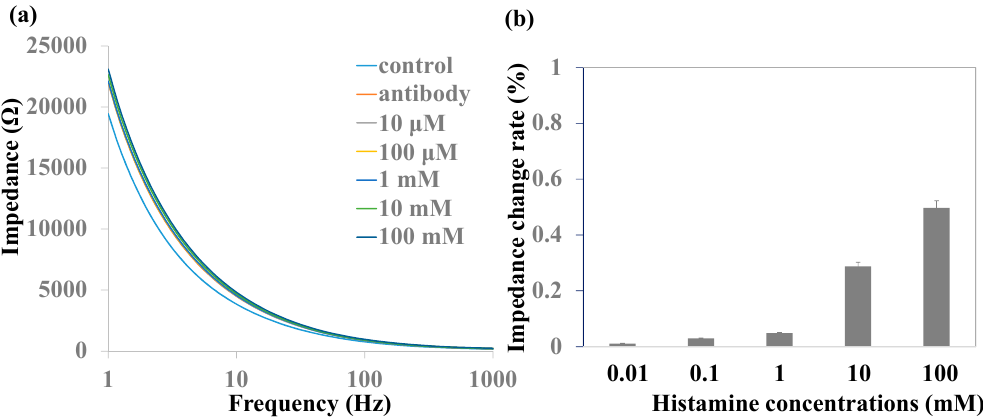
Figure 4. ( a ) Impedance spectra and ( b ) impedance change rate of various histamine concentrations without magnetic nanoparticles (MNPs).